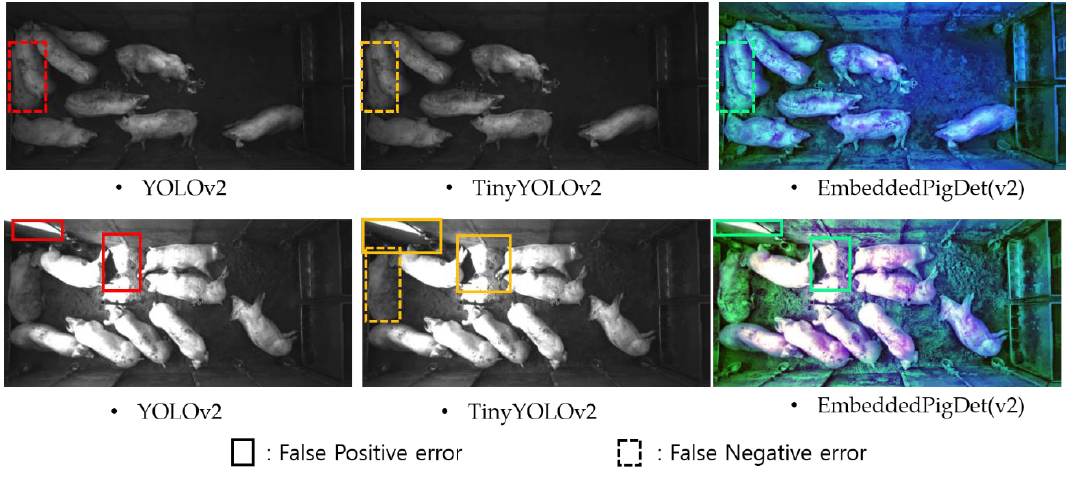
Figure 7. Failure cases for YOLOv2 [75], TinyYOLOv2 [75] and EmbeddedPigDet(v2).